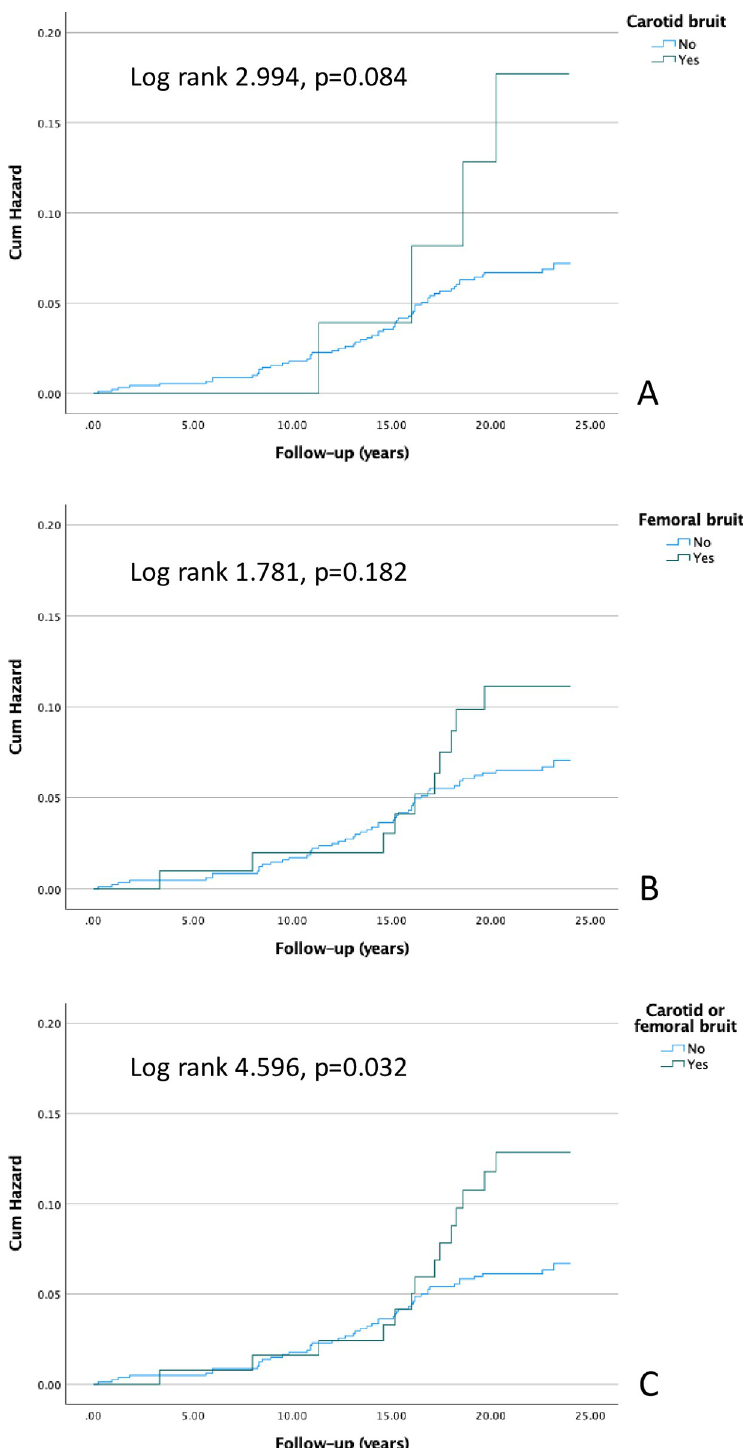
Fig 2. Kaplan-Meier curves presenting the cumulative hazards for cardiovascular deaths in patients with carotid bruit (A), femoral bruit (B), and carotid or femoral bruit (C).